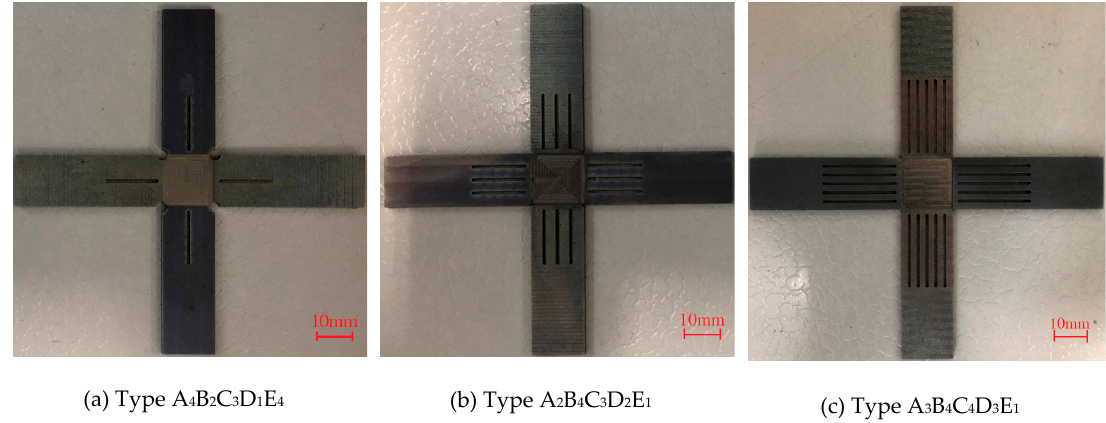
Figure 15. The specimen with various geometric types for biaxial tensile testing.